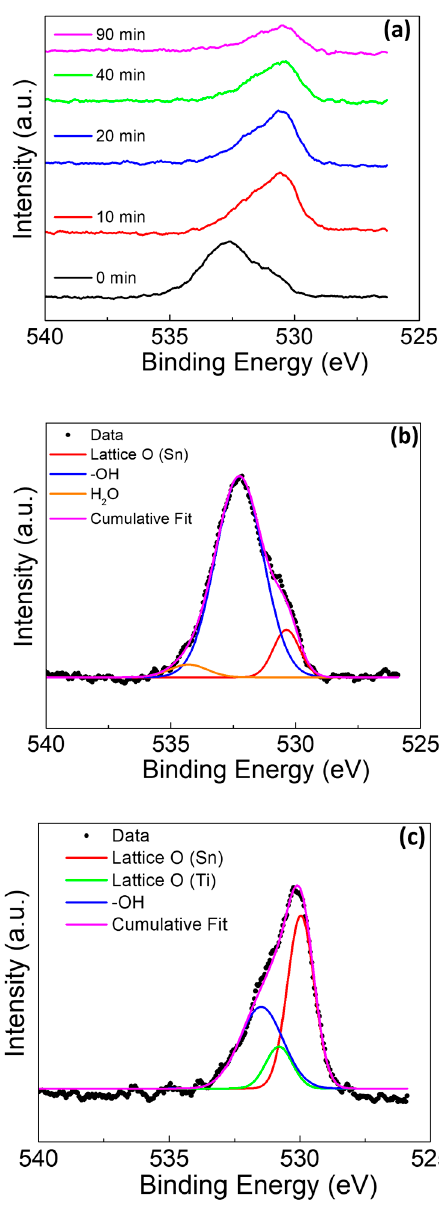
Figure 8. O 1s XPS of Ti rod with amalgam at pH 2 ( a ) at various sputter times, ( b ) at deconvolution of 0 min sputter time, and ( c ) at deconvolution of 20 min sputter time.